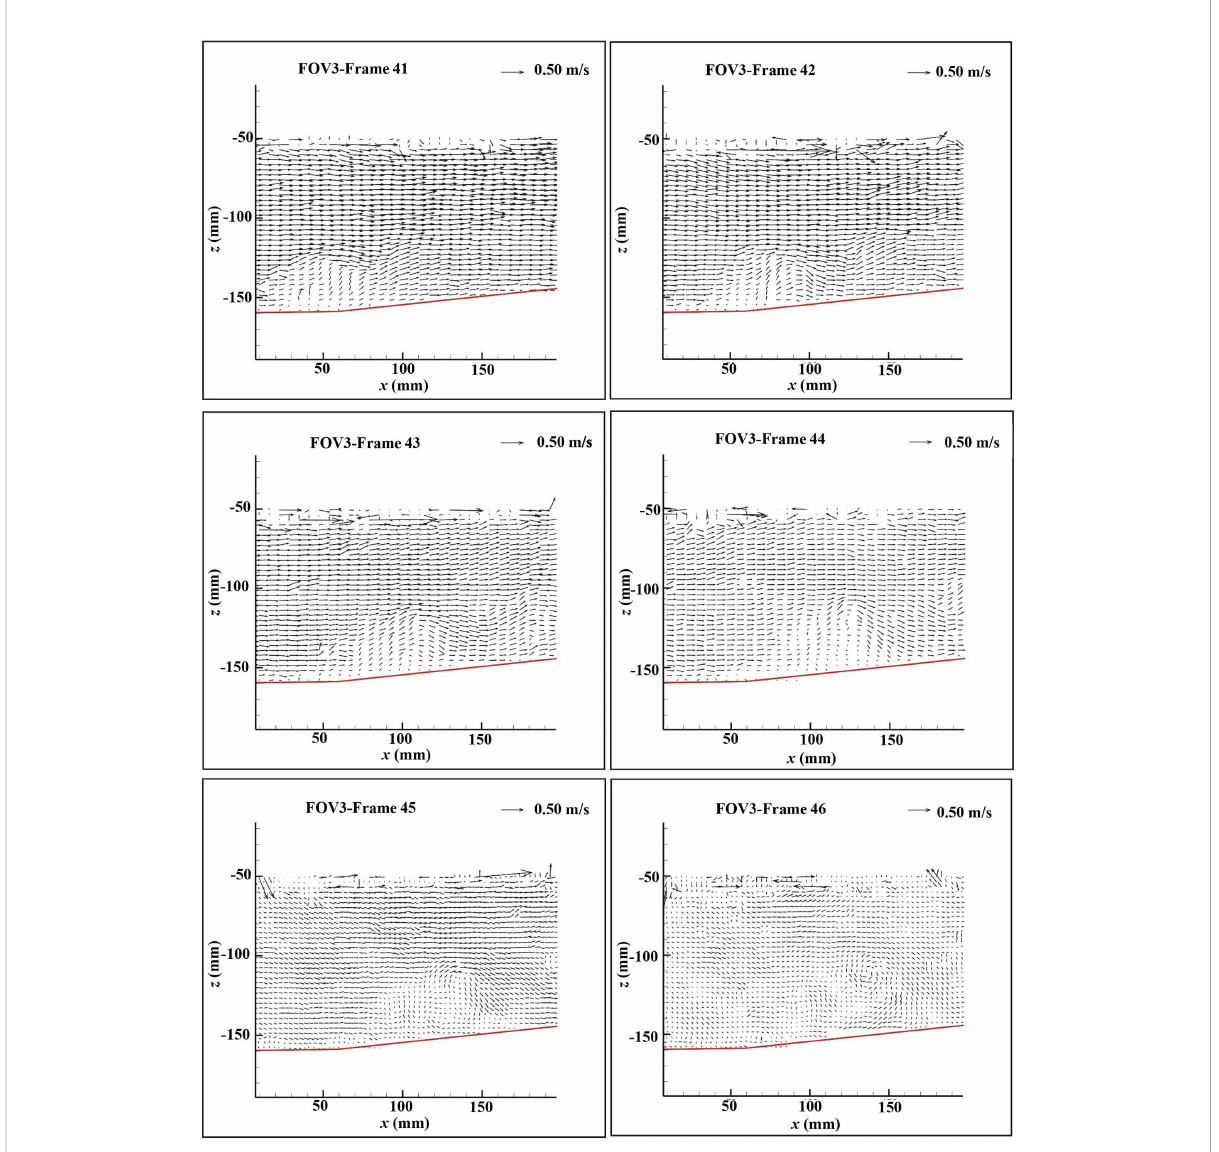
FIGURE 10 Formation of vortex structures at the location of beach slope transition on the composite